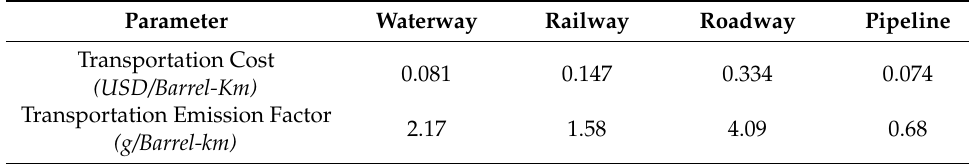
Table A2. Transportation-related parameter